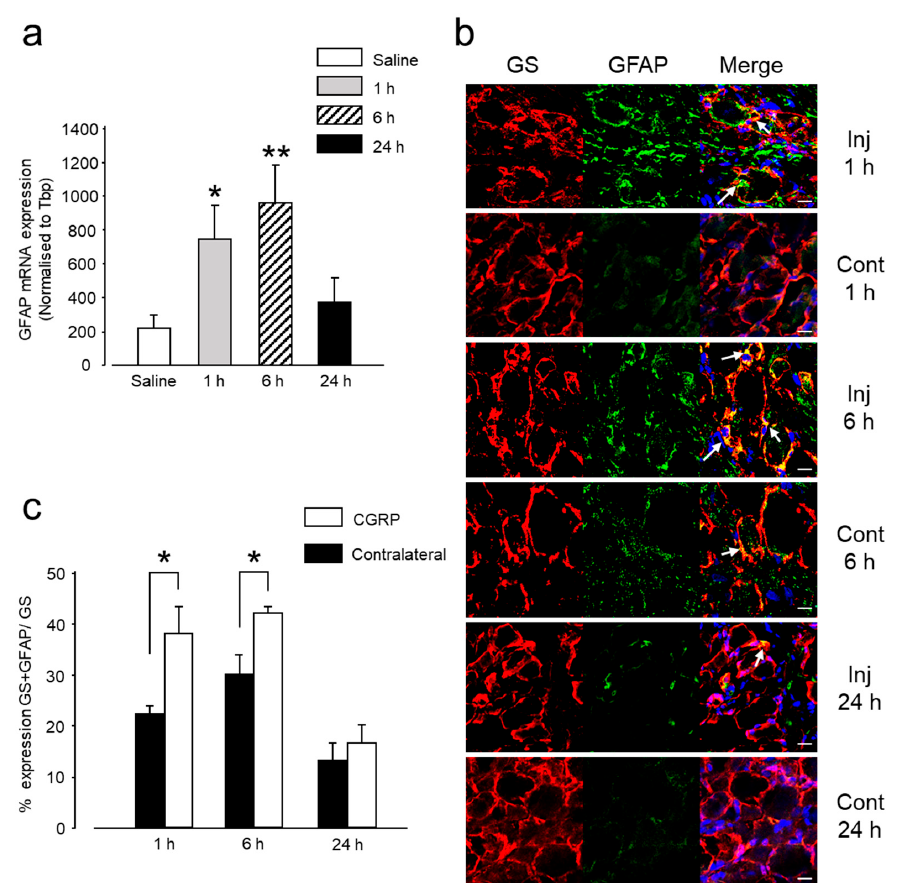
Figure 2. IG CGRP induced satellite glial cells (SGCs) activation. ( a ) The mRNA expression of glial fibrillary acidic protein (GFAP) in the trigeminal ganglion (TG) was significantly increased at 1 and 6 hours after IG CGRP administration. Results are presented as Mean ± SEM of the relative expression.